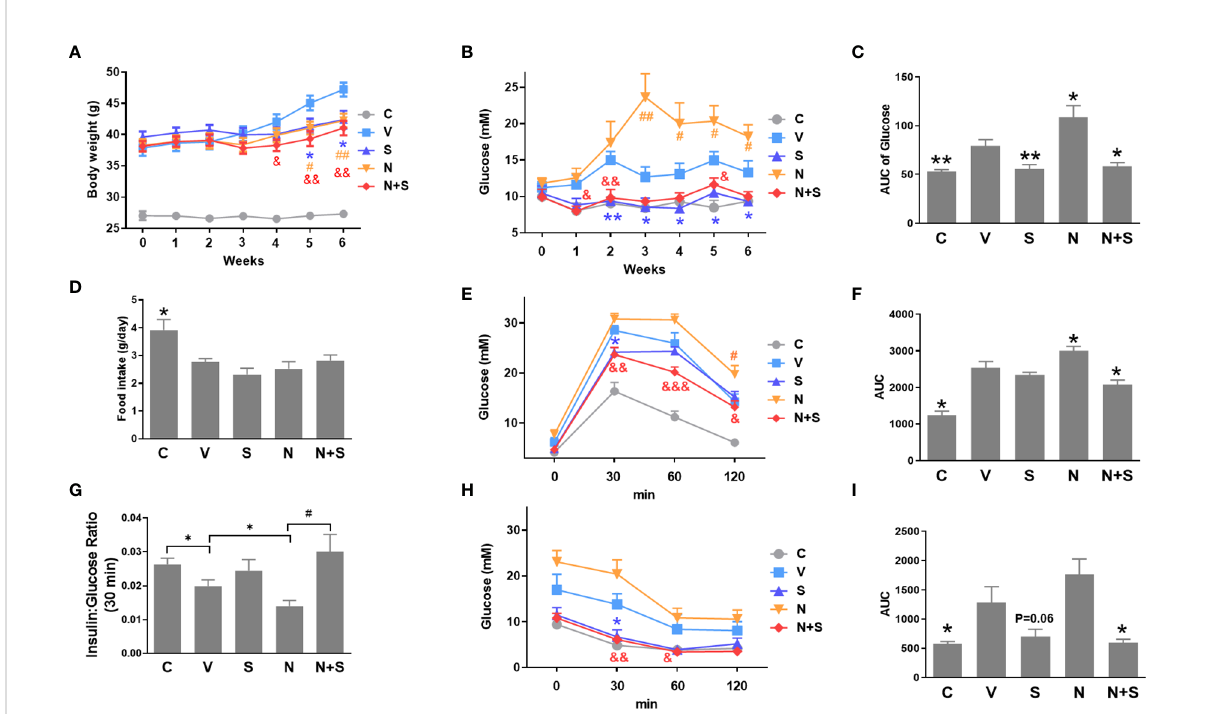
FIGURE 7 niacin exacerbates glucose intolerance in HFD-induced obesity mice and protection by DPP-4i sitagliptin. HFD mice or normal mice (C group) were treated with vehicle (V group), niacin (N group), sitagliptin (S group) or niacin plus sitagliptin (N+S group) for 6 weeks. Different metabolic indexes were detected during the experiment. (A) Body weight, (B, C) Random fed blood glucose levels and corresponding area under the curve (AUC). (D) 24 hours of food intake. OGTT was carried out after 4 weeks of treatment in mice. (E – G) glucose and corresponding AUC and 30- minute insulin and glucose ratio. (H, I) ITT results after 4 weeks of treatment. The results are displayed as the means ± SEM. n = 5-9. In C, D, F, G and I , *P < 0.05 and **P < 0.01 compared to the vehicle group; # P < 0.05 compared to the niacin group. In A, B, E and H , *P < 0.05 and **P < 0.01 the sitagliptin group compared to the vehicle group; # P < 0.05 and ## P < 0.01 the niacin group compared to the vehicle group; & P < 0.05, && P < 0.01 and &&& P < 0.001 the niacin plus sitagliptin group compared to the vehicle